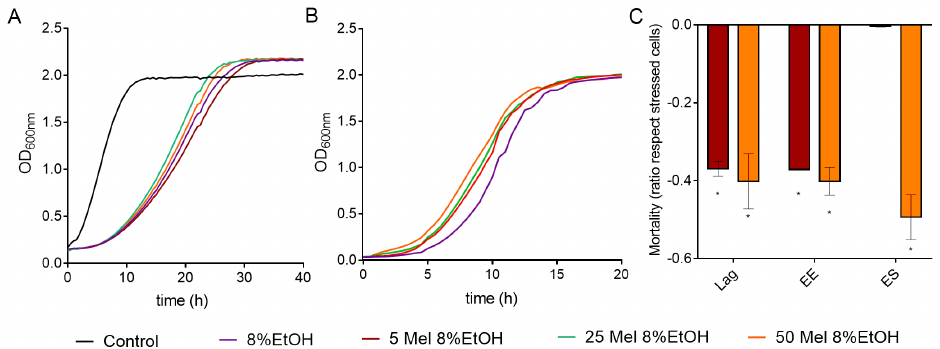
Figure 5. Effect of melatonin (Mel) supplementation of BY4743 cells exposed to 8% ethanol on ( A ) cell growth, ( B ) growth of cells previously exposed to ethanol and recovered at exponential phase, and ( C ) mortality of cells exposed to ethanol in lag, early exponential (EE), and early stationary (ES) phases (ratio of mortality in stressed cells with Mel vs. stressed cells without Mel). Nonstressed cells (black) and stressed cells with Mel supplementation: 0 (purple), 5 (maroon), 25 (green) or 50 (orange) μ M. Error bars represent standard deviation, and * represents significant differences between stressed cells with and without melatonin. In Supplementary Table S6 there is a more complete statistical analysis of Graph C.